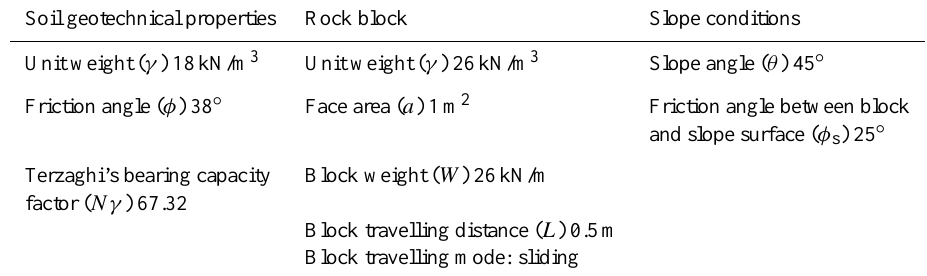
Table 3. Geotechnical, geometrical and topographical data used to calculate the maximum penetration depth of the